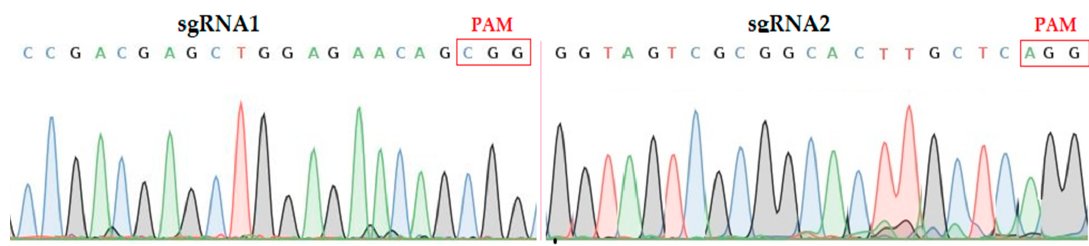
Figure 1. Sequencing chromatograms of both target sites assembled in vector. sgRNA; single guided RNA, PAM; protospacer adjacent motif.